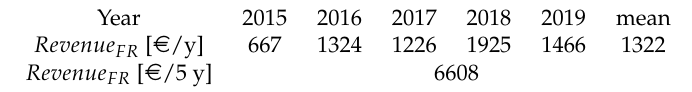
Table 2. Revenue FR for the 5 years of frequency regulation and sum of the 5 years.